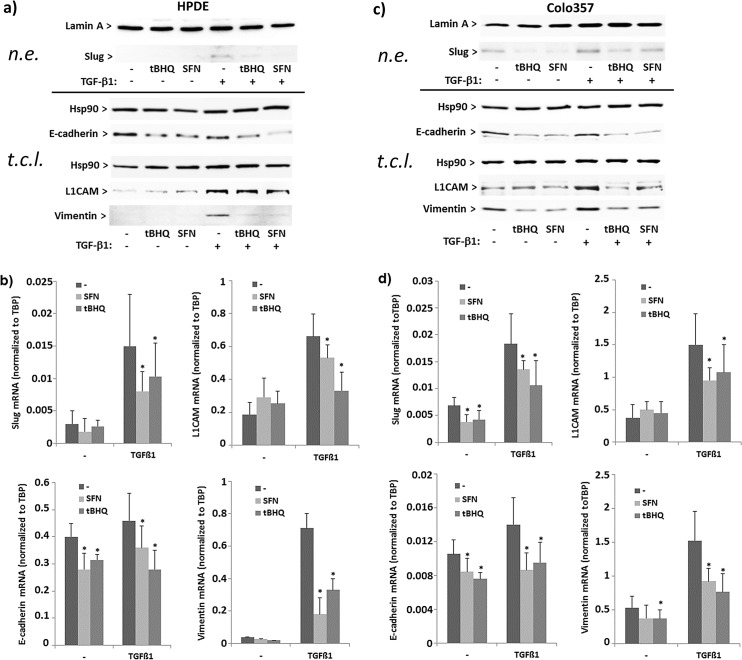
Effect of Nrf2 activation and TGF-β1 on the expression of EMT markers in premalignant HPDE and malignant Colo357 pancreatic duct cells.HPDE or Colo357 cells incubated with 50 μM tBHQ, 10 μM SFN or 10 ng/mL TGF-β1 alone or in combination or without for 24h. Then, either nuclear extracts (n.e.) or total cell lysates (t.c.l.) were analysed by westernblot (A,C), or RNA samples were analysed by real-time PCR (B,D) for the expression of Slug, L1CAM, E-cadherin or vimentin. Lamin-A/C and Hsp90 were used as loading controls for the westernblots of nuclear extracts and total cell lysates, respectively (A,C), and for normalization of Slug, L1CAM, E-cadherin and vimentin mRNA level TBP was analysed in parallel (B,D). Either a representative result from three independent experiments (A,C) or the mean ± SD from six independent experiments (B,D) are shown, *p<0.05 (+ tBHQ and + SFN versus–tBHQ and–SFN, respectively); (A,C) a densitometric band intensity evaluation is provided in Figs. A and B in S3 File.